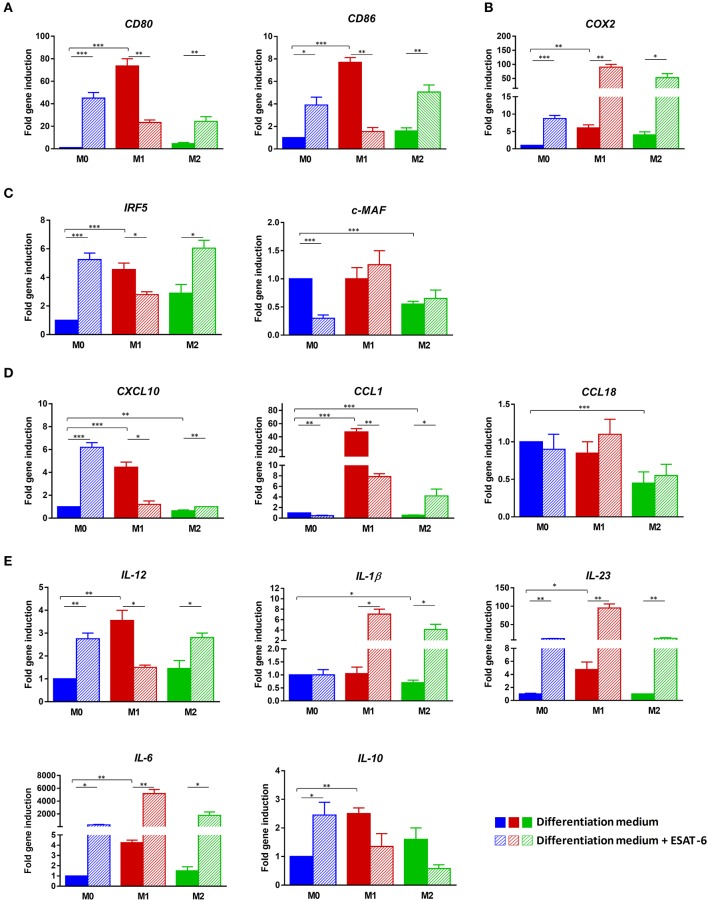
ESAT-6 directs M0 and M2 macrophage differentiation toward the M1 phenotype. Non-polarized M0 MΦs, pro-inflammatory M1 MΦs and anti-inflammatory M2 MΦs were differentiated from human purified monocytes as above-indicated. Cells were either treated or not treated with 10 μg/mL ESAT-6. After 6 days of MΦ differentiation, mRNAs were extracted and expression levels of different MΦ markers were assessed by RT-qPCR. Fold changes in gene expression of (A) Cell surface molecules CD80 and CD86, (B)
COX2, (C) Transcription factors IRF5 and c-MAF, (D) Chemokines CXCL10, CCL1, and CCL18, as well as (E) Cytokines IL-12, IL-1β, IL-23, IL-6, and IL-10 are shown. Data are presented as the mean ± SD of 3 separate experiments (i.e., 3 different donors), each one carried out in triplicate.